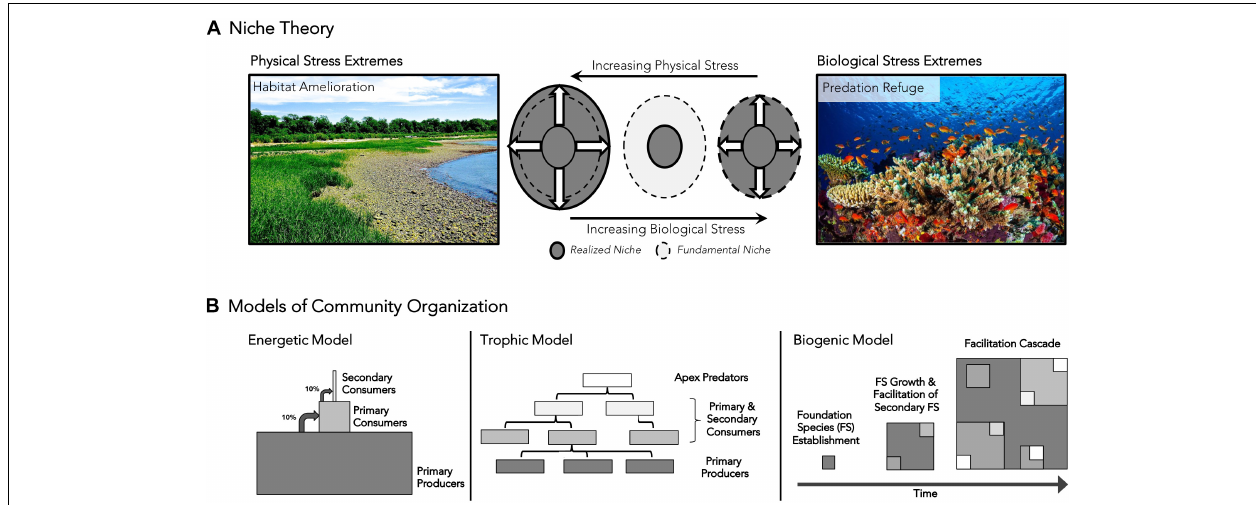
FIGURE 2 | Conceptual models incorporating positive interactions into (A) niche theory (adapted from Crotty and Bertness, 2015) and (B) models of community organization. (A) Contradicting traditional niche theory, this model predicts that the realized niche will be larger than the fundamental niche in physically stressful habitats through habitat amelioration and will be identical to the fundamental niche in biologically stressful habitats through associational defenses. The areas enclosed by dashed lines represent the fundamental niche space. Gray areas outlined by solid black lines represent realized niche space along physical and biological stress gradients. Physical stress extremes (left) are shown as cobble beach habitats, where most littoral organisms are unable to persist without the presence of the foundational cordgrass. Biological stress extremes are shown (right) within marine environments, where corals provide refuge to smaller prey species, allowing them to persist in areas otherwise exposed to high rates of predation-related mortality. (B) Traditional energetic models, food web trophic models, and biogenic model of community organization are presented to highlight conceptual differences about community organization. Lighter shapes signify higher trophic levels, while dark colors signify basal tropic levels in all panels. The biogenic model considers the cascading effects of multiple, overlapping foundation species and niche segregation within a foundation species template through time.